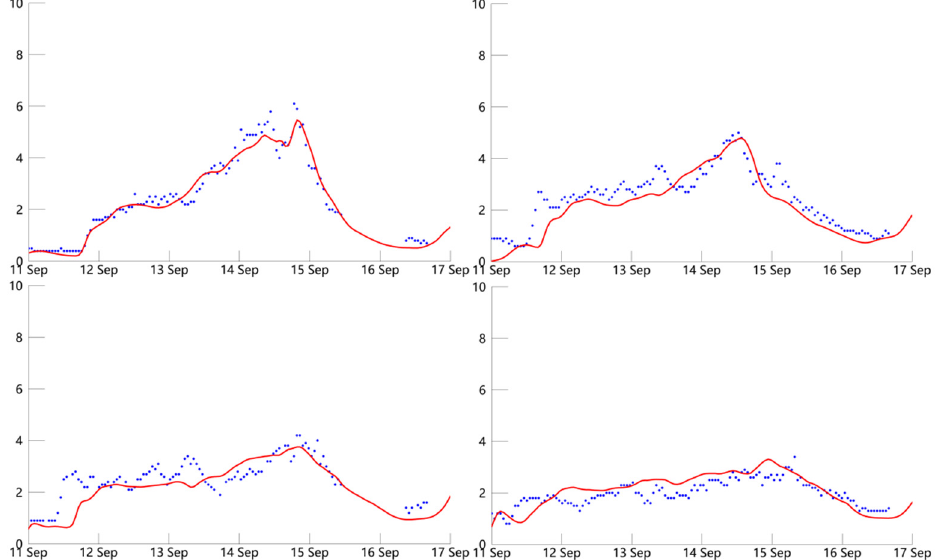
Figure 13. The temporal distributions of significant wave heights (m) obtained from experiment 20 (red line) and buoy observations (blue dot) during typhoon Meranti at the locations of four buoys. The mean skill scores of each physical scheme for the three typhoon events are shown